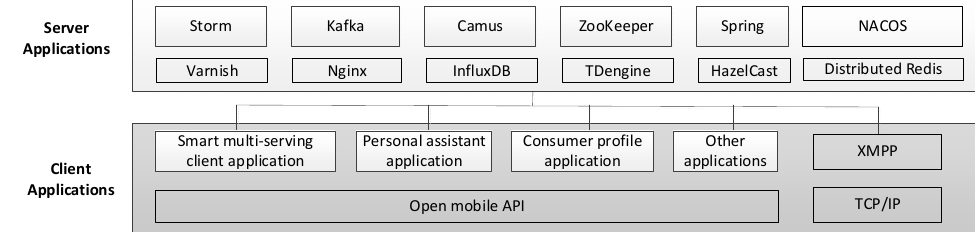
Figure 12. The utilized model for the development of software applications for EMULSION.